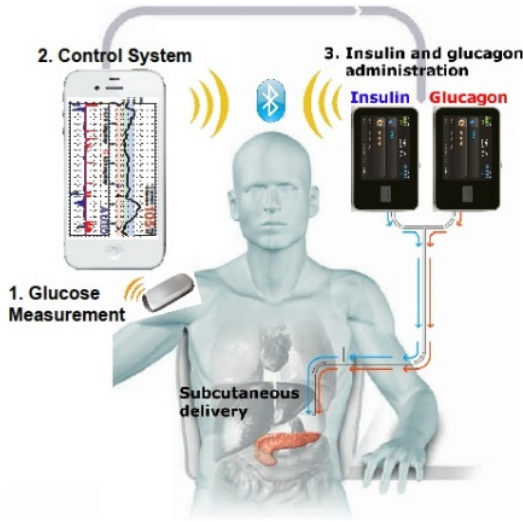
Figure 11. The bionic pancreas device system (available online: http://fortune.com/2014/06/16/ apple ‐ powered ‐ bionic ‐ pancreas ‐ one ‐ step ‐ closer/, accessed on 3 December 2015).